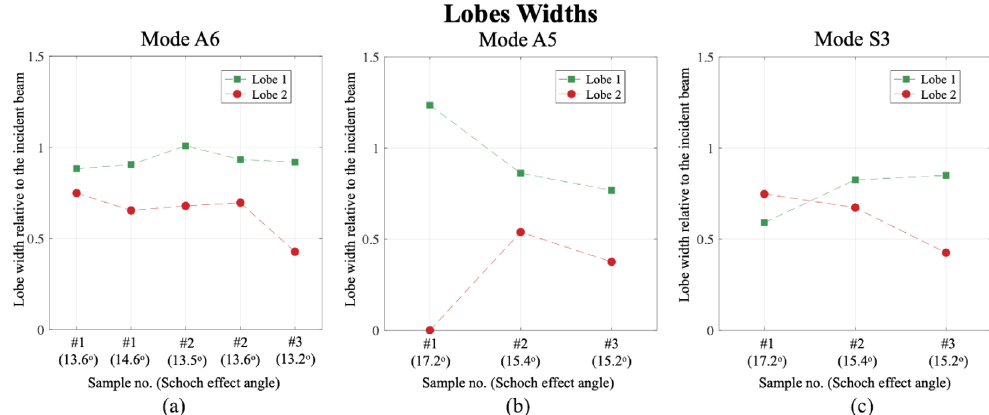
Figure 9. Relative width (ratio of the width of a lobe to that of the incident beam) for modes A6, A5, and S3.